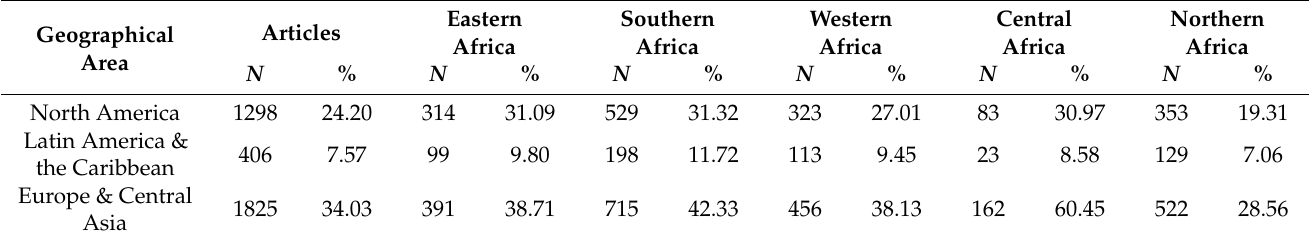
Table 1. Scientific production on COVID-19, broken down by geographical region. N represents the number of articles and % the